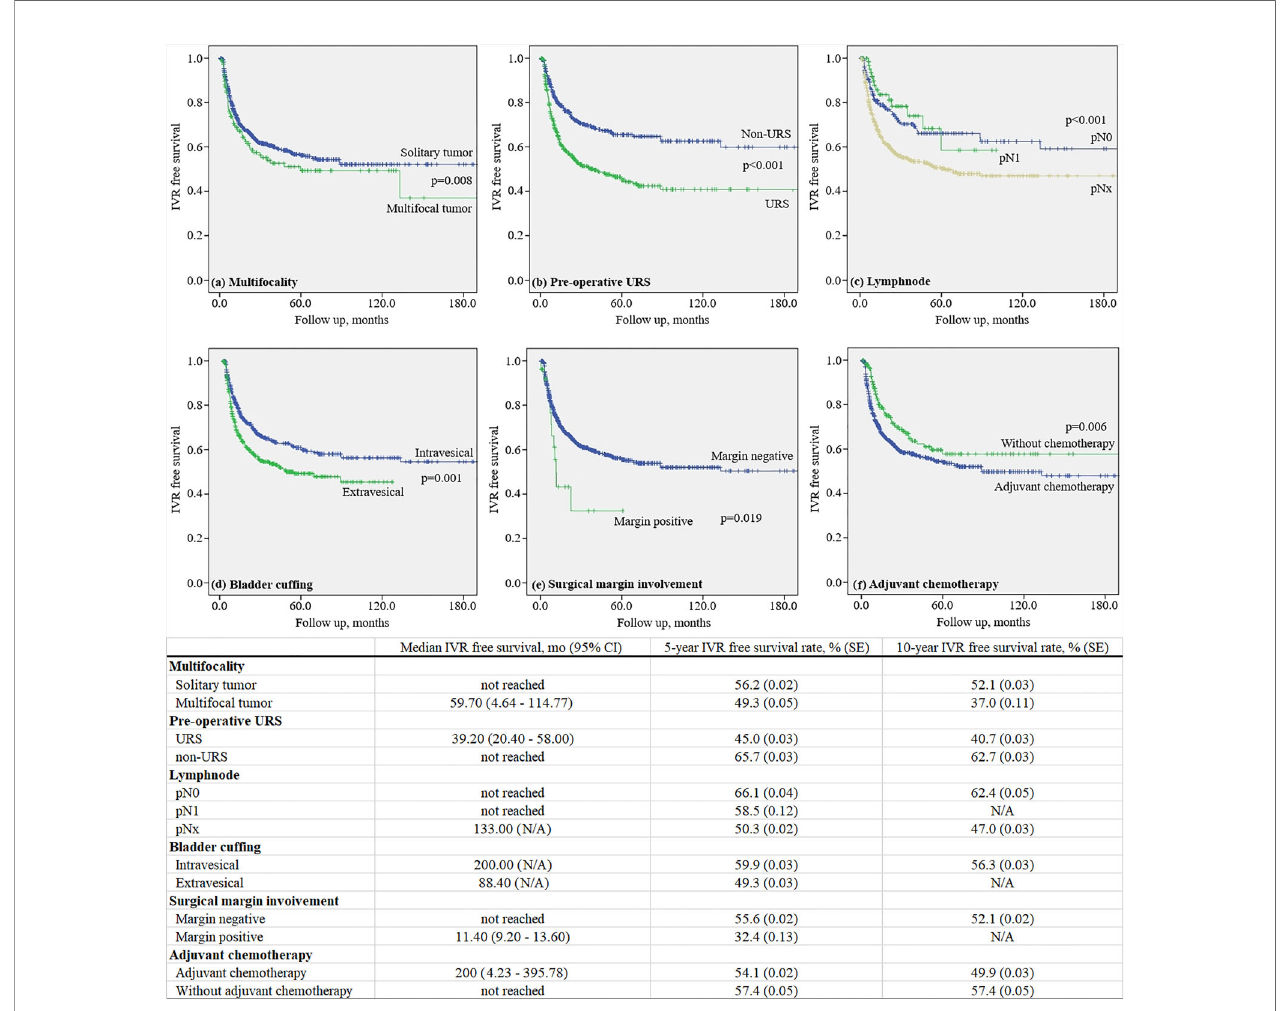
FIGURE 2 | Kaplan – Meier curve for intravesical recurrence in patients without a history of bladder